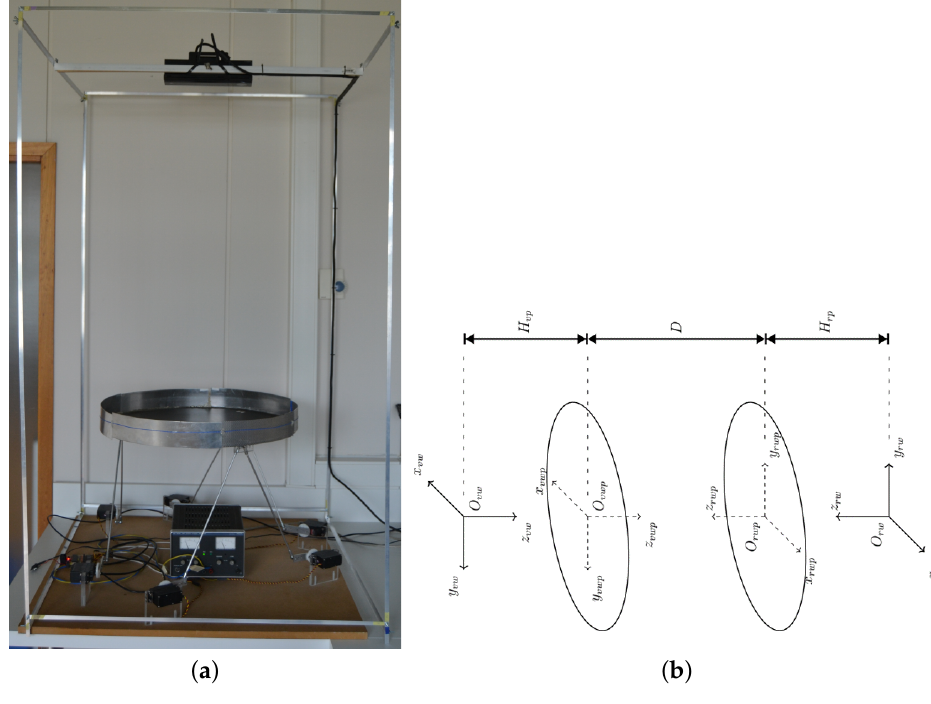
Figure 2. ( a ) Real world six degree of freedom (6DOF) platform for co-simulation, including a frame and Kinect IR-camera; ( b ) Relation between coordinate systems of the real world and the virtual